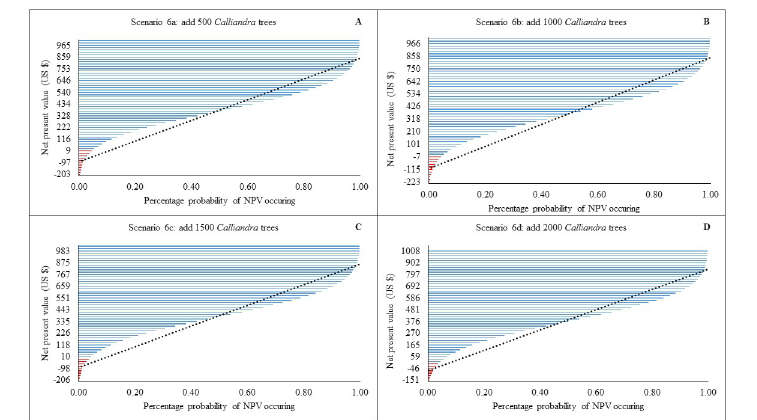
Fig 7. Modelled probability (%) changes in Net Present Value (NPV) for scenarios 6a-d of providing a nectar crop ( C . calothyrsus ). Red lines indicate loss and blue lines profit. Dotted black line is a linear forecast. NPVs to the right of the line indicate optimal profit/loss attained for each an intervention